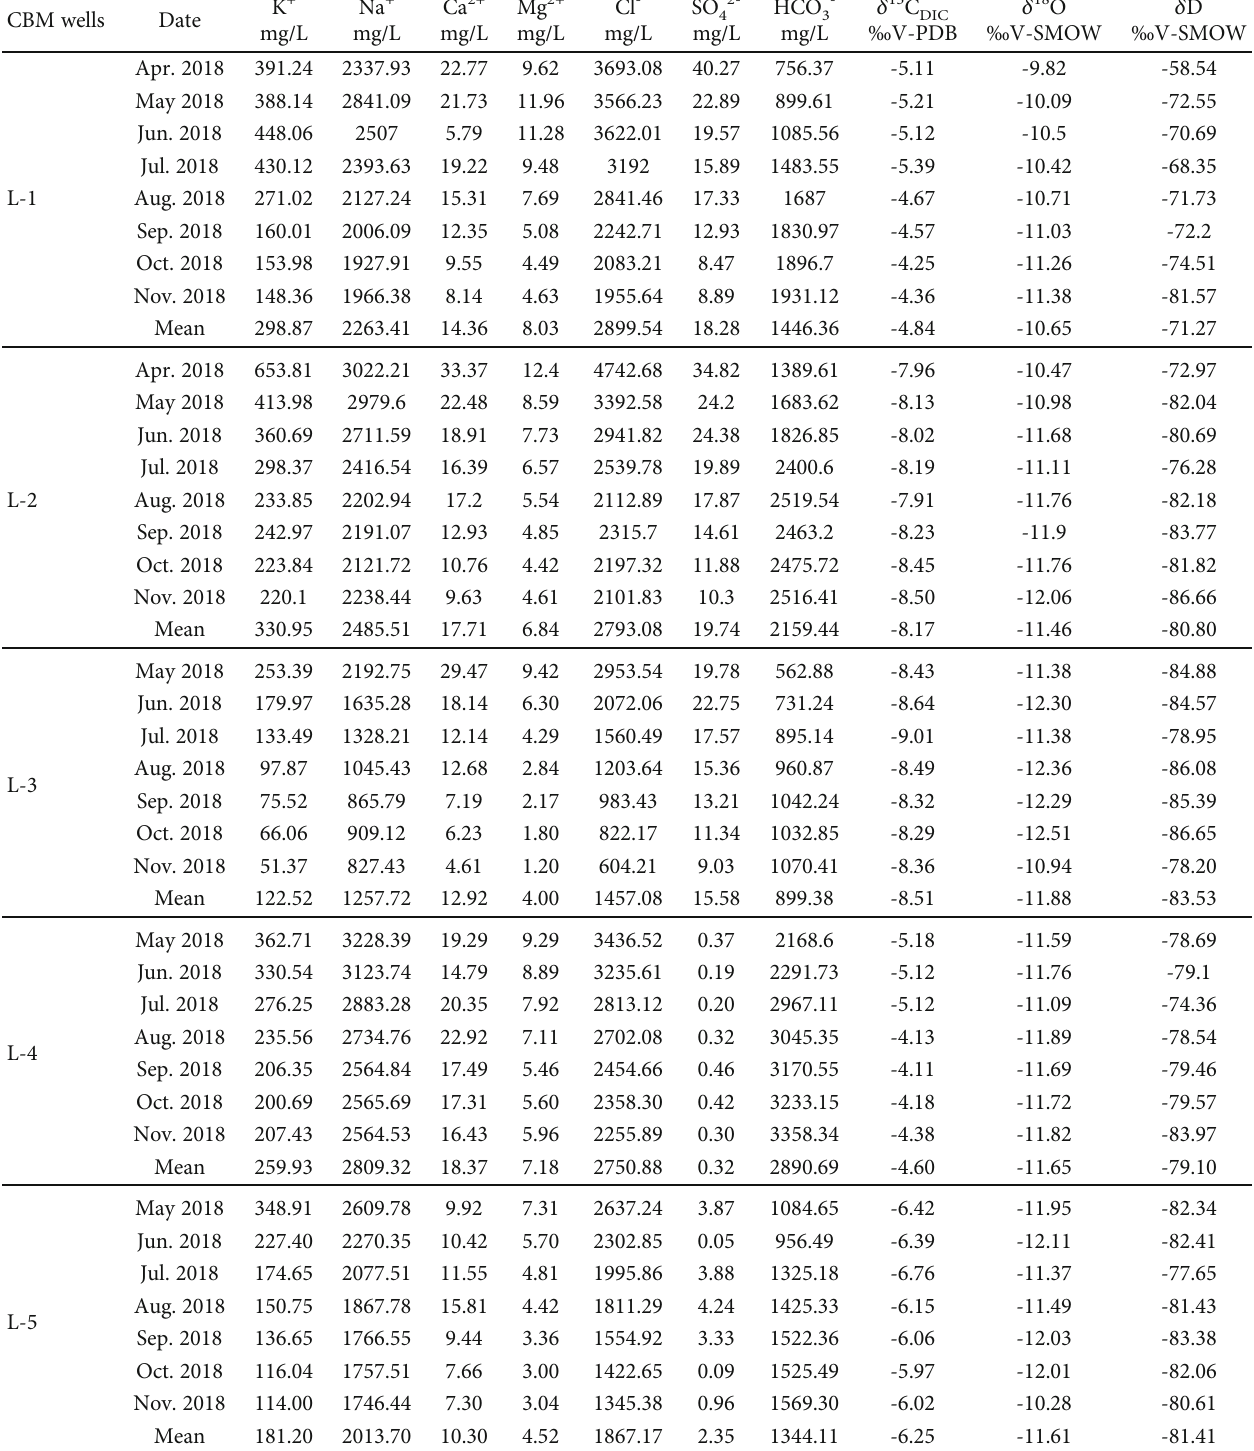
Table 2: Conventional ion data and hydrogen and oxygen isotope data from water samples. CBM